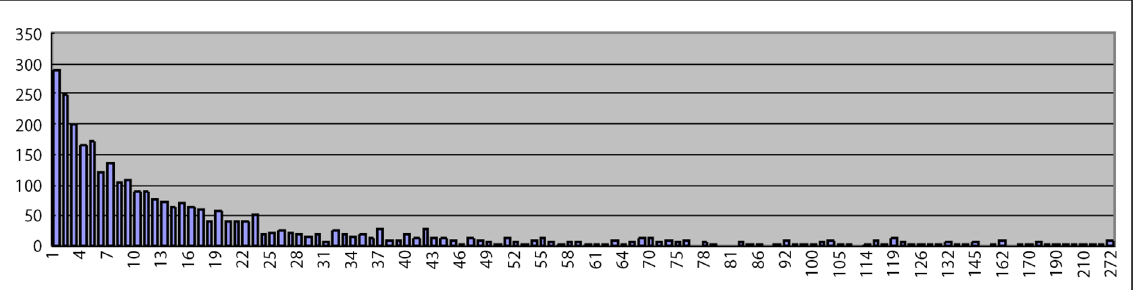
Figure 7. Degree distribution of the HIV-targeted human proteins in human PPI network. The horizontal axis denotes protein degree and the vertical axis denotes the number of proteins that possess that degree.